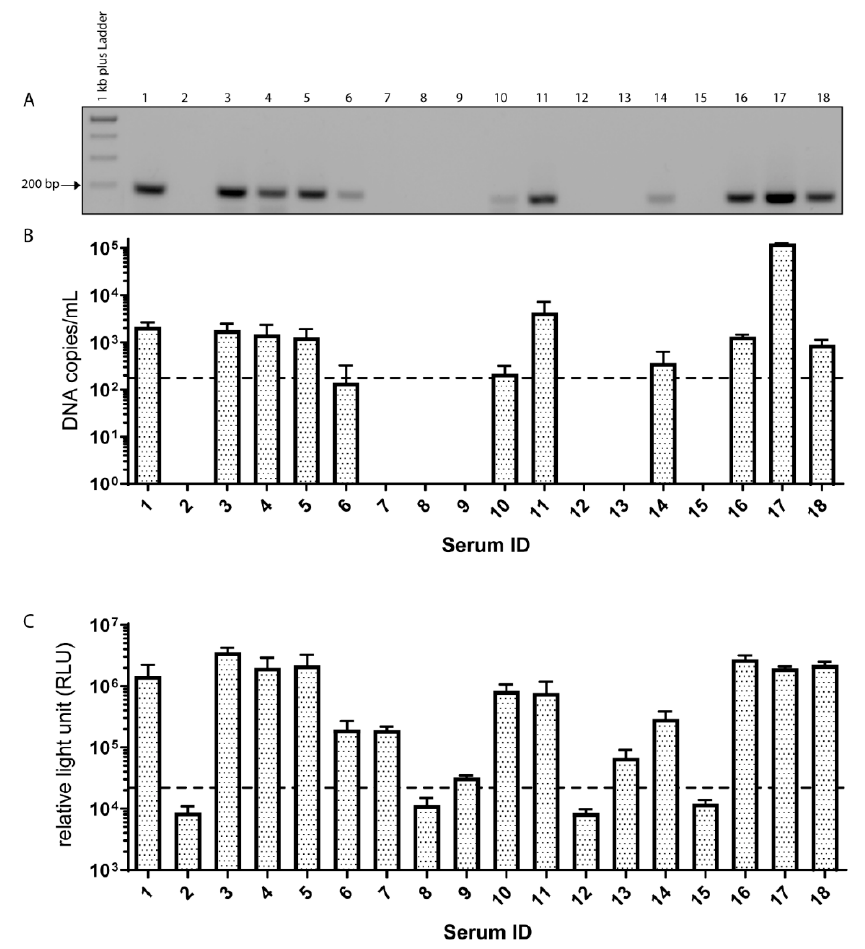
Figure 1. Occurrence of EqPV-H DNA and antibodies within commercial serum samples. ( A ) Agarose gel electrophoresis of quantitative PCR of commercial serum pools. ( B ) Viral loads of EqPV-H were determined using qPCR and are displayed in DNA copies/mL. The dotted line indicates the limit of detection. Every bar represents the mean of 5 technical replicates performed in 3 independent measurements. ( C ) Depicted are anti-EqPV-H antibodies as RLU measured in triplicates. The cut-off was determined by the mean value of the EqPV-H negative serum plus 3*SD and is indicated by a dashed line.